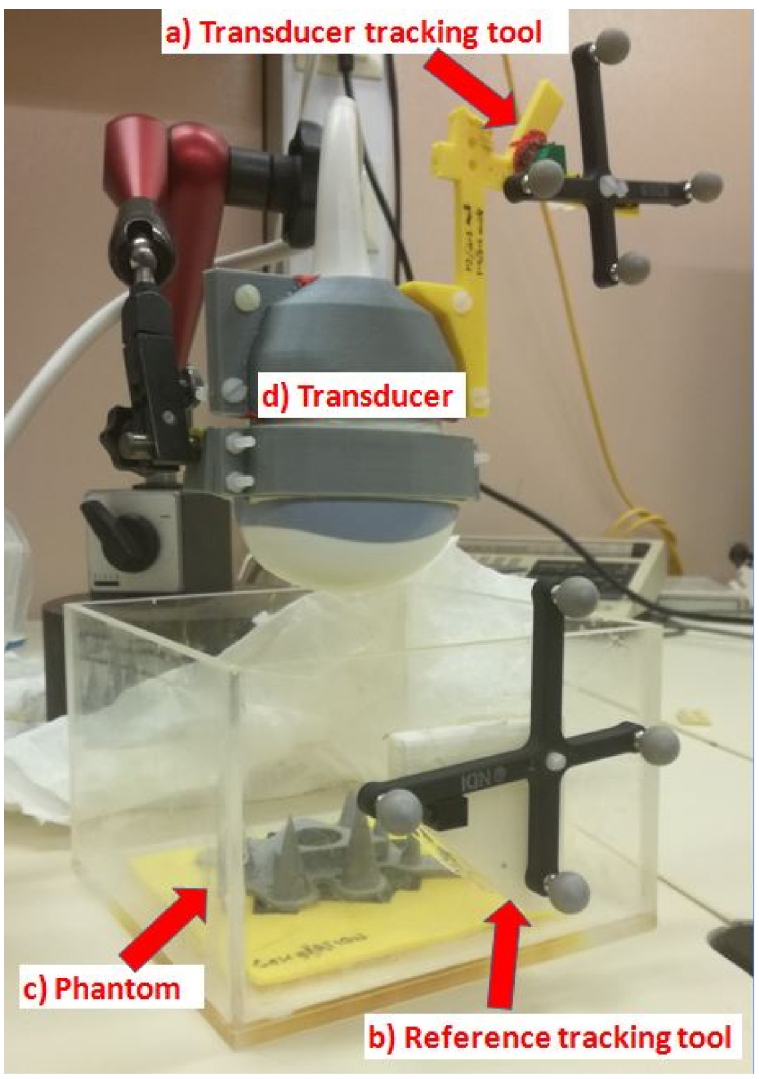
Fig 2. Setup for the transducer (d) calibration procedure: The phantom (c) was placed in a fixed position inside the water tank with a tracking tool attached on the tank (b) and on the transducer (a). The mechanical arm held the transducer in a constant position during image